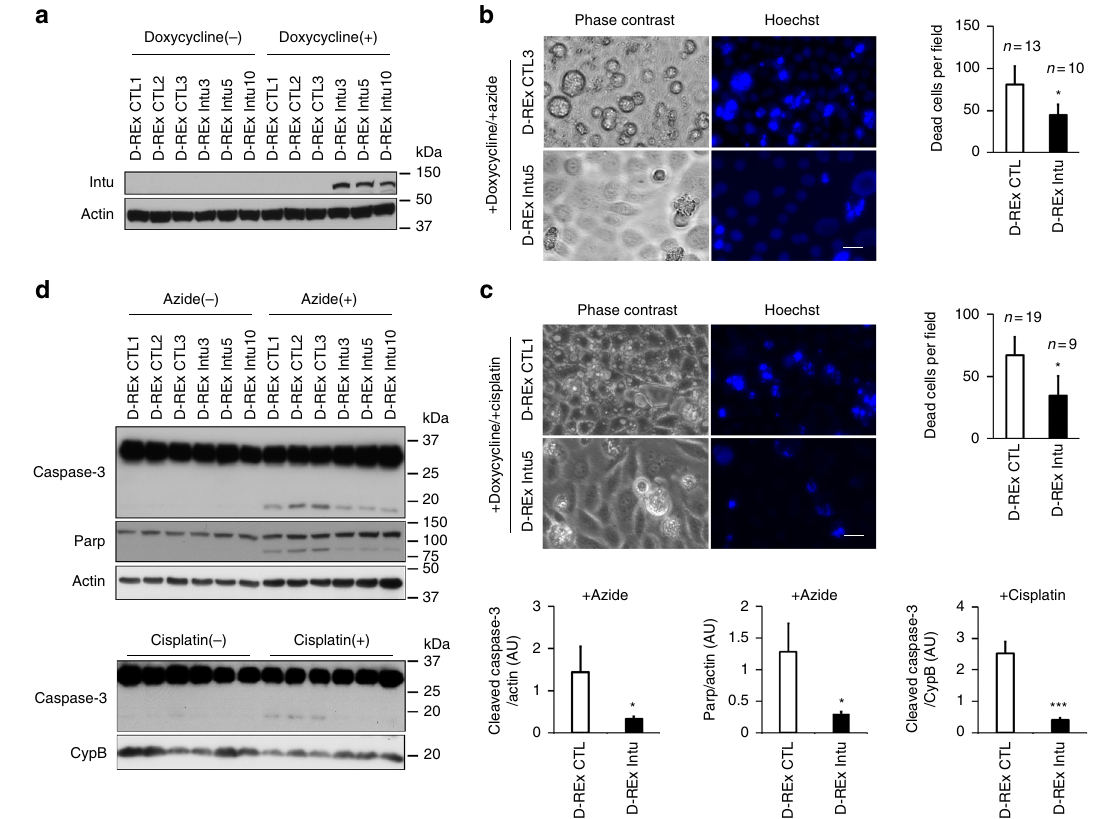
Fig. 3 Inducible Intu expression suppresses cell death. a Inducible Intu expression in RPTC cells. Three inducible cell clones (D-REx Intu3, 5, 10) were treated with doxycycline to induce Intu expression shown by immunoblotting in comparison to three empty vector controls (D-REx CTL1, 2, 3). b Less cell death was observed in Intu-expressing cells after azide treatment. c Resistance of Intu-expressing cells to cisplatin treatment. d Immunoblot analysis of Caspase-3 and Parp cleavage to con fi rm less apoptosis in Intu-expressing cells after azide or cisplatin treatment. Quantitative data are mean ± s.d. (error bars). Grouped t test was used . * p < 0.05, *** p < 0.001. Scale bar: 20 µ